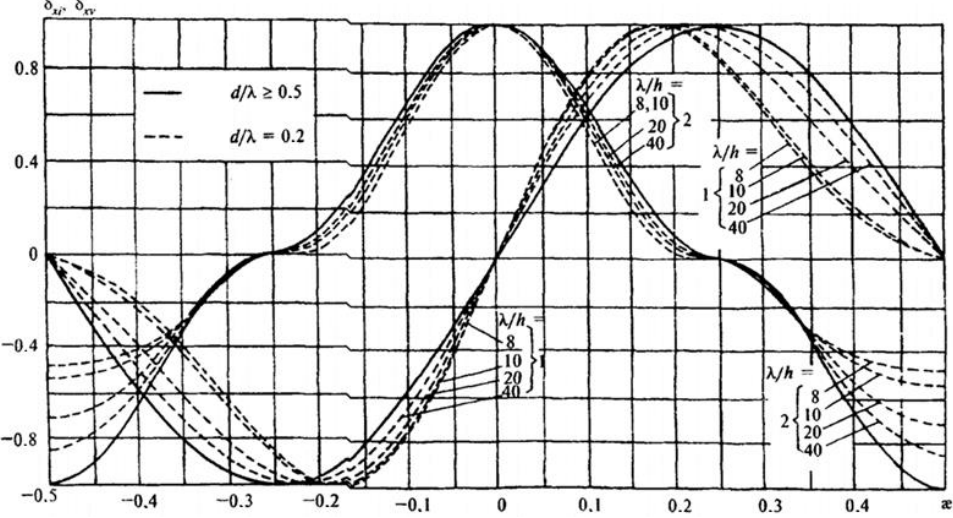
Figure 2. The graph of the values of coefficients of the inertial load combination δ xi (graph 1) and velocity load combination δ xv (graph 2) components of the horizontal linear load from waves (æ—distance from the crest of the wave) [15]. Table 7. The empirical coefficient value k v